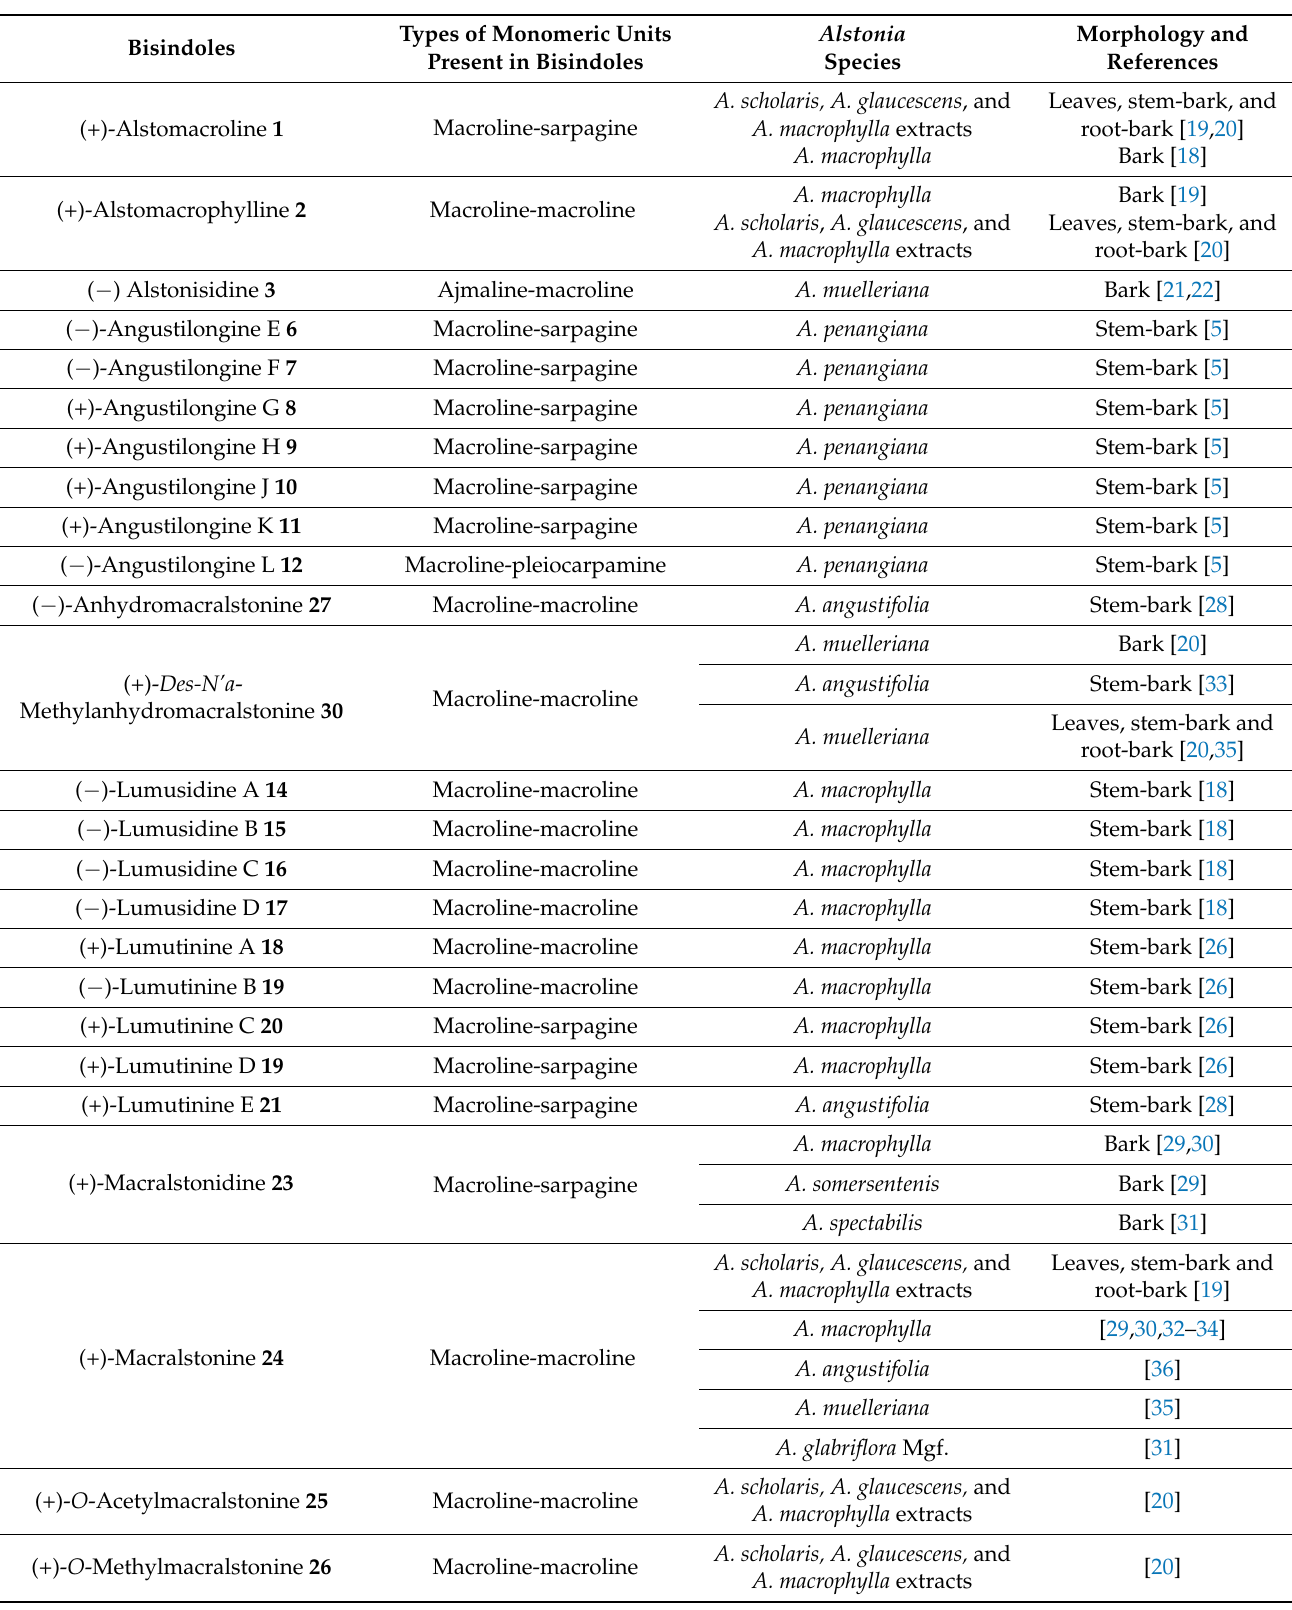
Table 3. Isolation and plant morphology of bisindole alkaloids from Alstonia